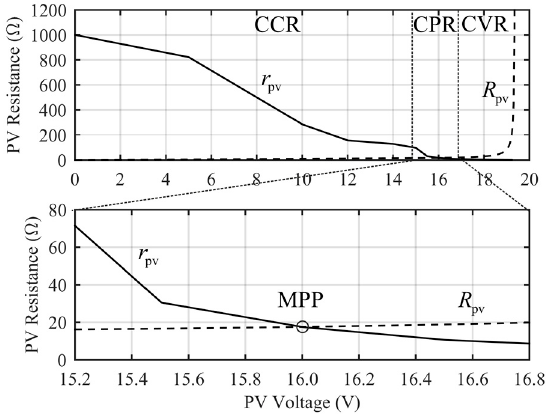
Figure 6. Authentic behavior of dynamic and static resistances of Raloss SR30-36 PV panel ( top ); and their extended view ( bottom ).